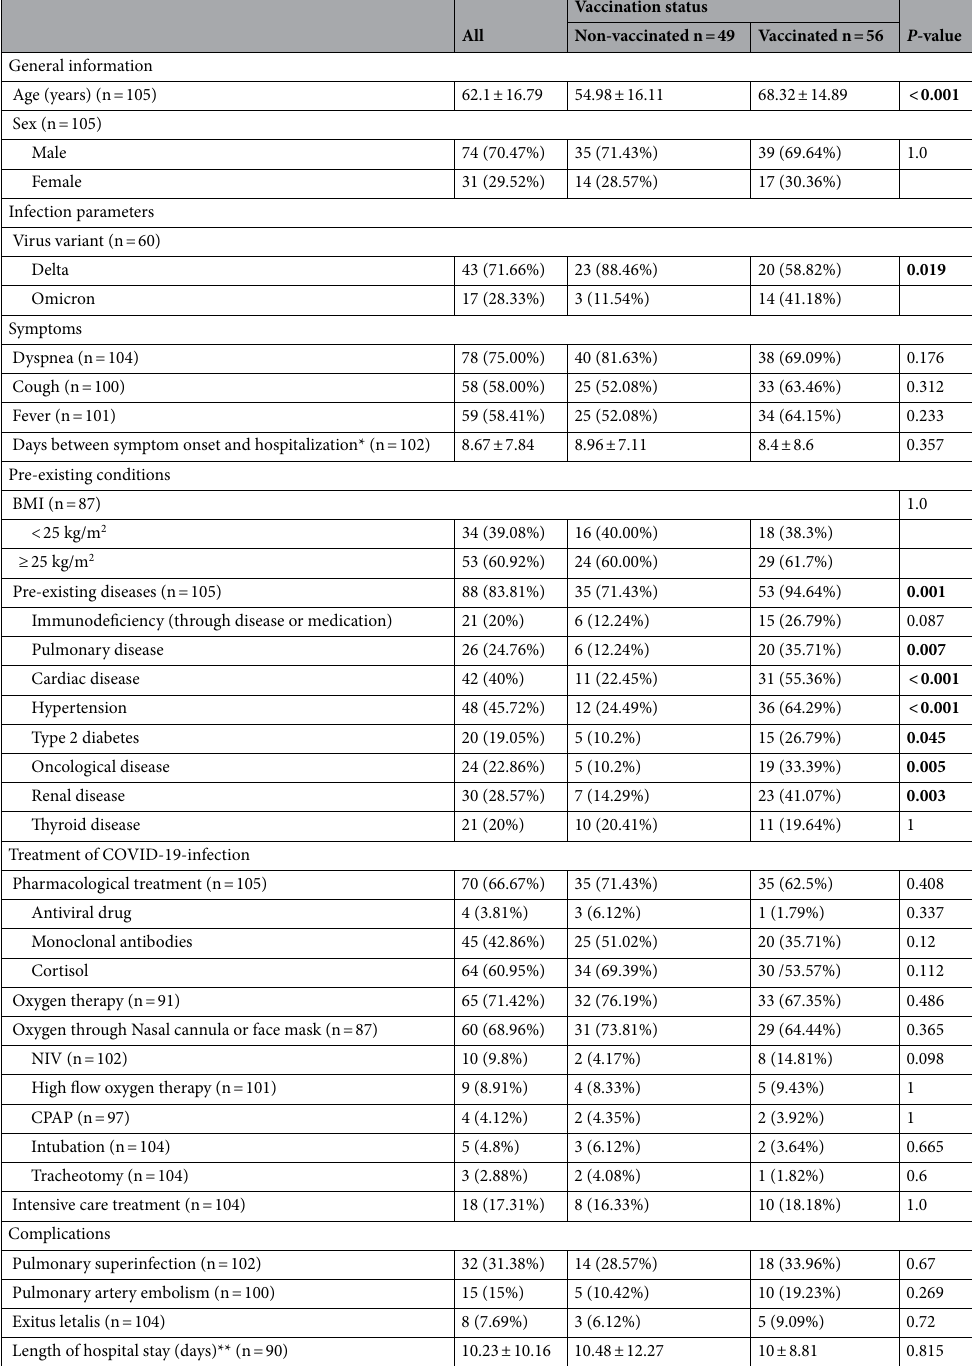
Table 1. Patients’ demographic and clinical factors according to vaccination status. For continuous variables, values are mean ± standard deviation (SD) with p ‐ values from t-test. For categorical variables, values are counts and percentages with P ‐ values from Fisher’s Exact Test. BMI body mass index, NIV non-invasive ventilation, CPAP continuous positive airway pressure. Patients developing COVID-19 infection during a hospital stay were excluded from the analysis regarding the days between symptom onset and hospitalization (*); patients with exitus letalis were excluded from the analysis regarding the length of hospital stay (**). Significant P -value < 0.05. Significant values are in